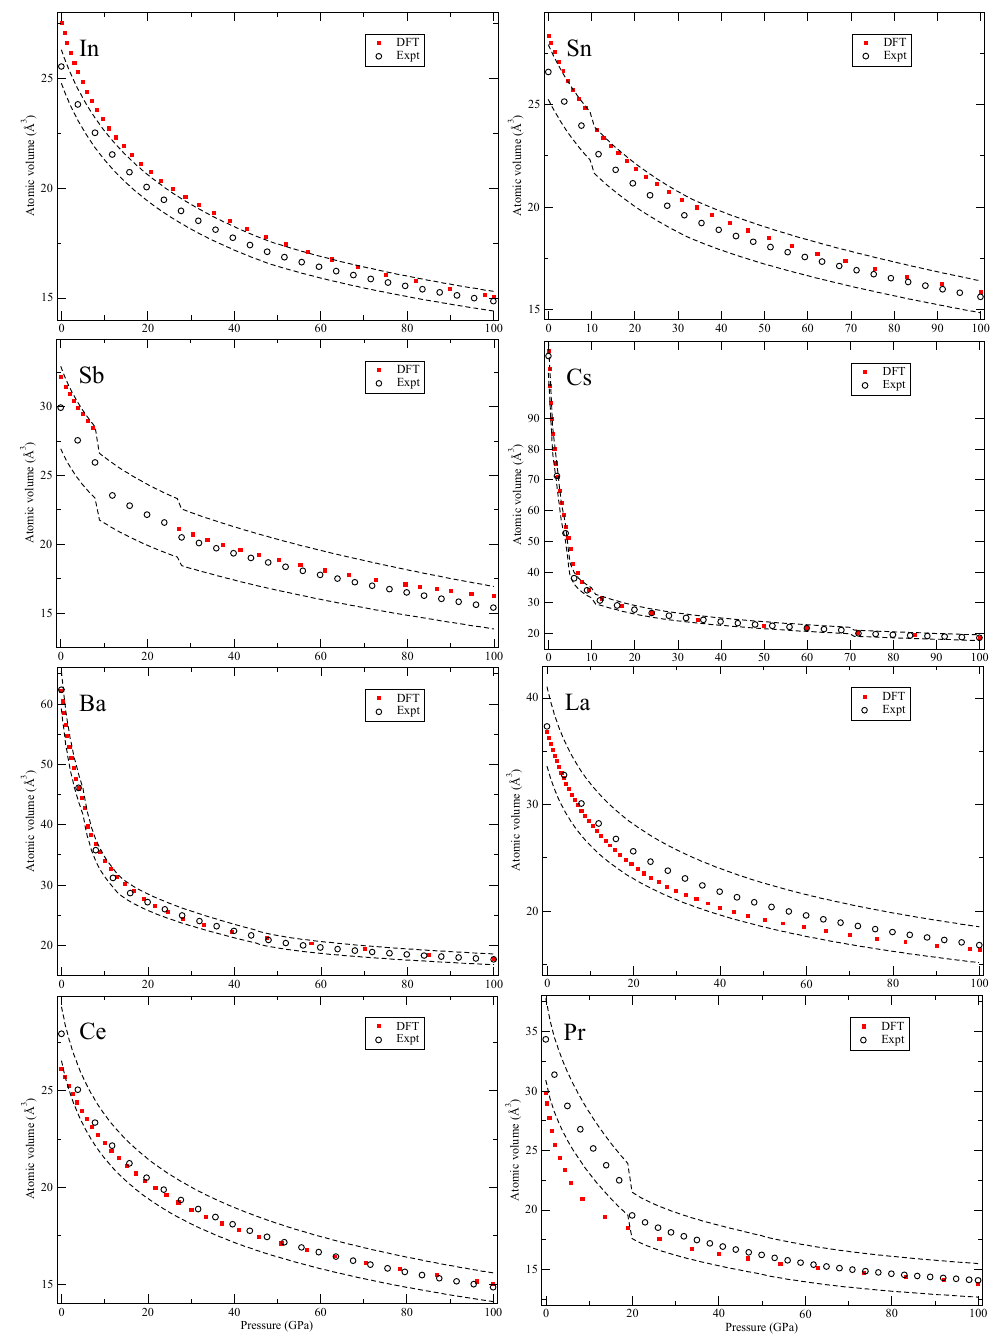
Figure 6. Experimental and DFT EOS for In, Sn, Sb, Cs, Ba, La, Ce and Pr.